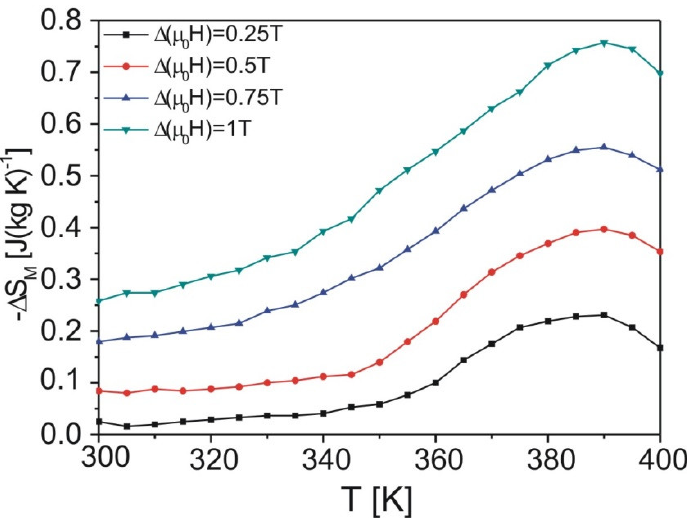
Figure 5. The temperature dependence of magnetic entropy change of the as-cast Fe 60 Co 12 Gd 4 Mo 3 B 21 alloy. Figure 6 plots thermomagnetic isotherms M 2 vs. (H/M) called Arrott plots obtained near the Curie temperature of the studied sample. The Arrott plots have positive show and show almost straight lines. The Banerjee criterion [15] describes differences in slope of the Arrott plots and its relation with order of the phase transition. The shape of Arrott plots, presented in Figure 6, confirms second order phase transition of the investigated